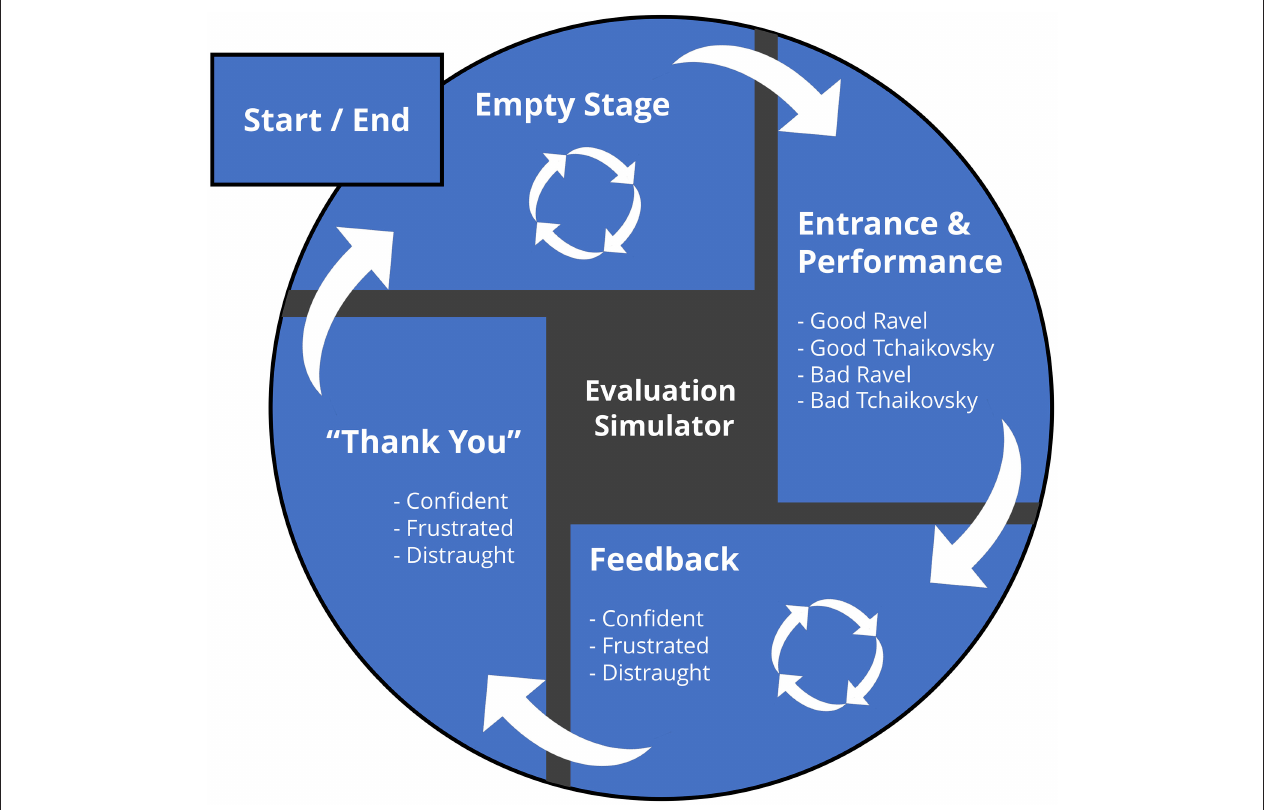
FIGURE 4 | Process mapping of the software interface. Following a hold of the empty stage shot, pressing keys 1–4 triggers the stage entrance and respective performance. During this performance, selecting the “b” or “c” keys prompts the eventual transition to the appropriate reaction (which otherwise goes to the default confident ). Once the looped feedback reaction is no longer needed (which can be quickly skipped in scenarios in which no immediate verbal feedback is provided), the space bar triggers the stage exit and returns the software to the original stage, ready for another